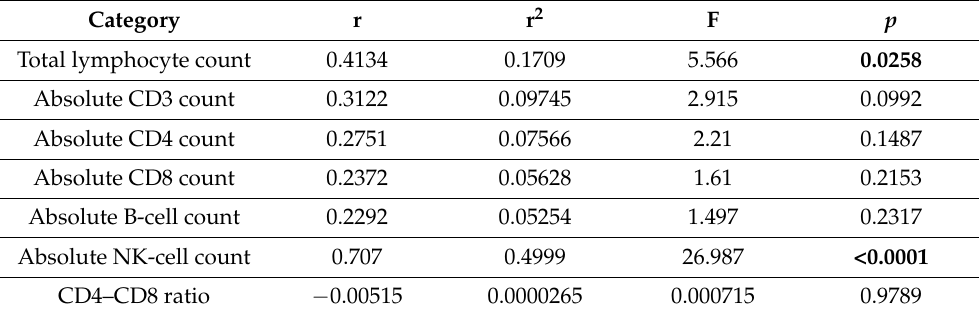
Table 2. CTC number/absolute lymphocyte count correlations (linear regression analysis). Bold is used here to highlight significant values ( p <